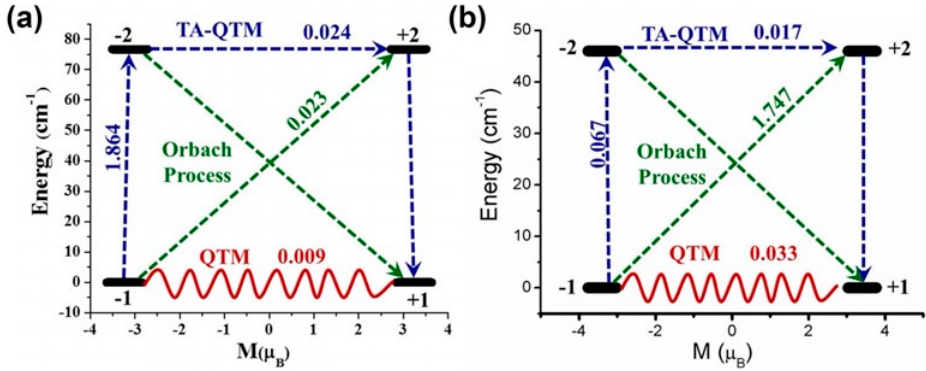
Figure 17. Ab initio computed matrix elements between the connecting pairs (ground state and first excited state) in complexes 27 ( a ) and 27 ′ ( b ). The thick black line indicates the Kramer’s doublets (KDs) as a function of magnetic moment. The dotted green lines show the possible pathway of the Orbach process. The zigzag lines connecting the ground state KDs represent the QTM. The dotted blues lines show the thermally activated-QTM through the first excited state. Figures and captions are reproduced from Reference [54] with permission from the